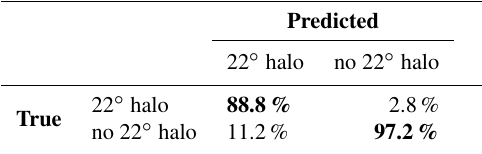
Table 4. Confusion matrix as in Table 3 for 470 randomly selected HaloCam images between January 2014 and June 2016, evaluated for segments 3, 4 and 5. The true positives (correctly classified “22 ◦ halo”) are printed in bold font.